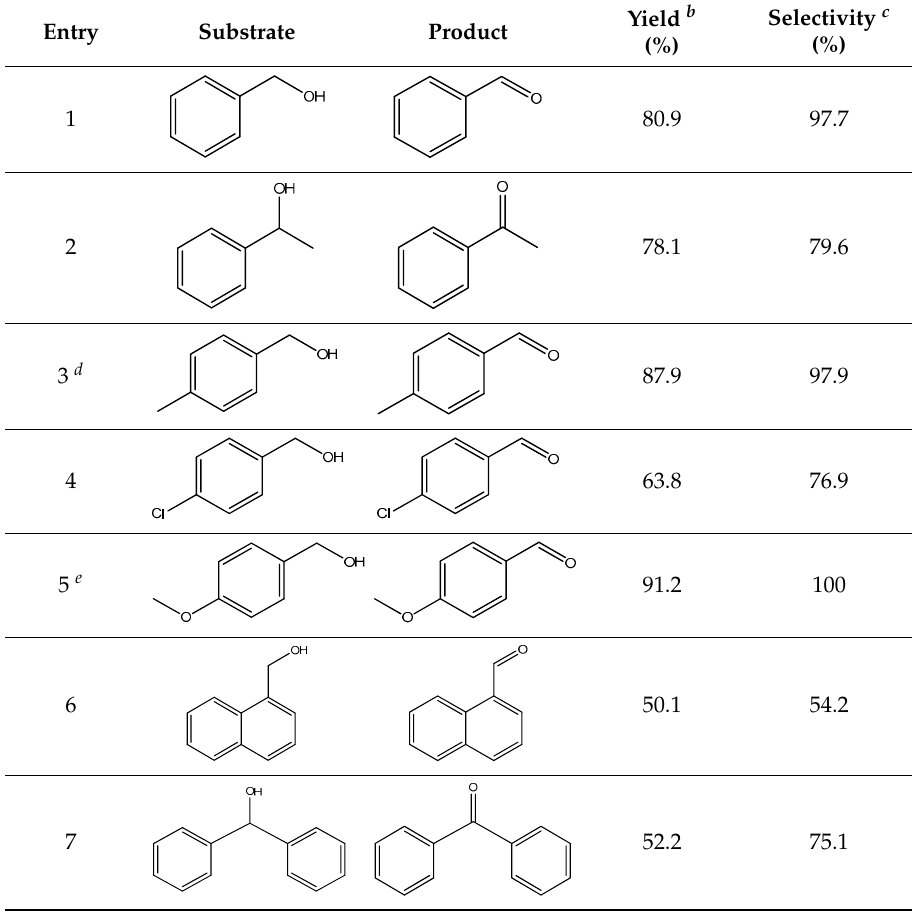
Table 1. Photocatalytic selective oxidation of various aromatic alcohols on Au 2 Pt 2 /N–TiO 2 a